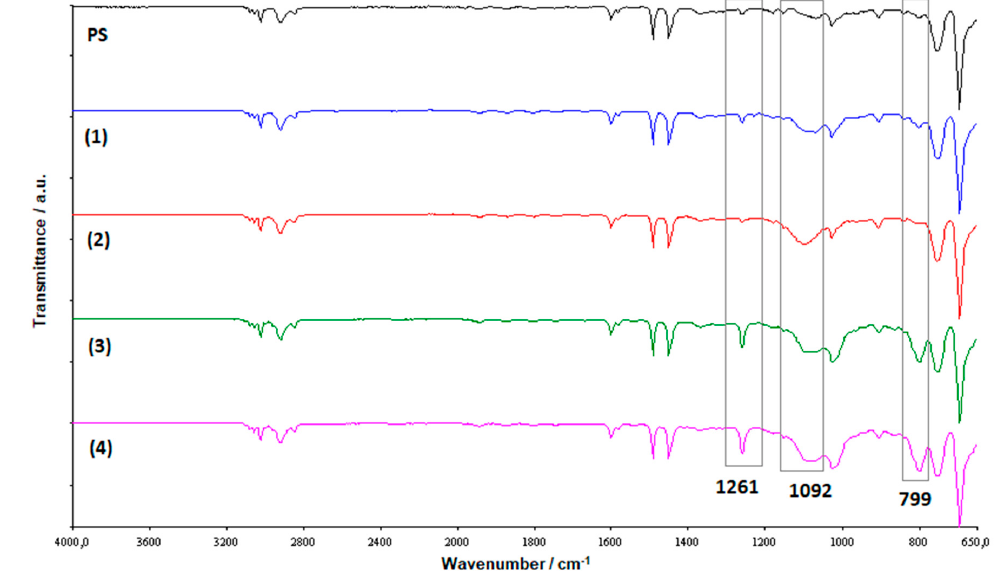
Figure 5. FTIR spectra of PS and prepared nanocomposites.